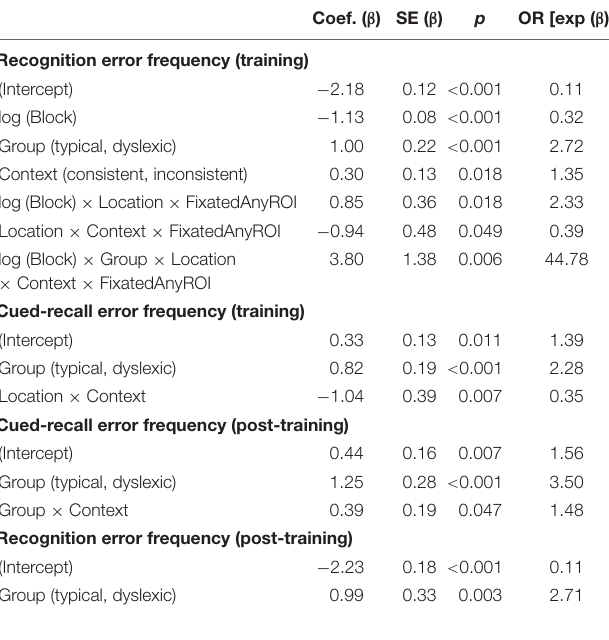
TABLE 3 | Summaries of logistic mixed effects regression analyses of error